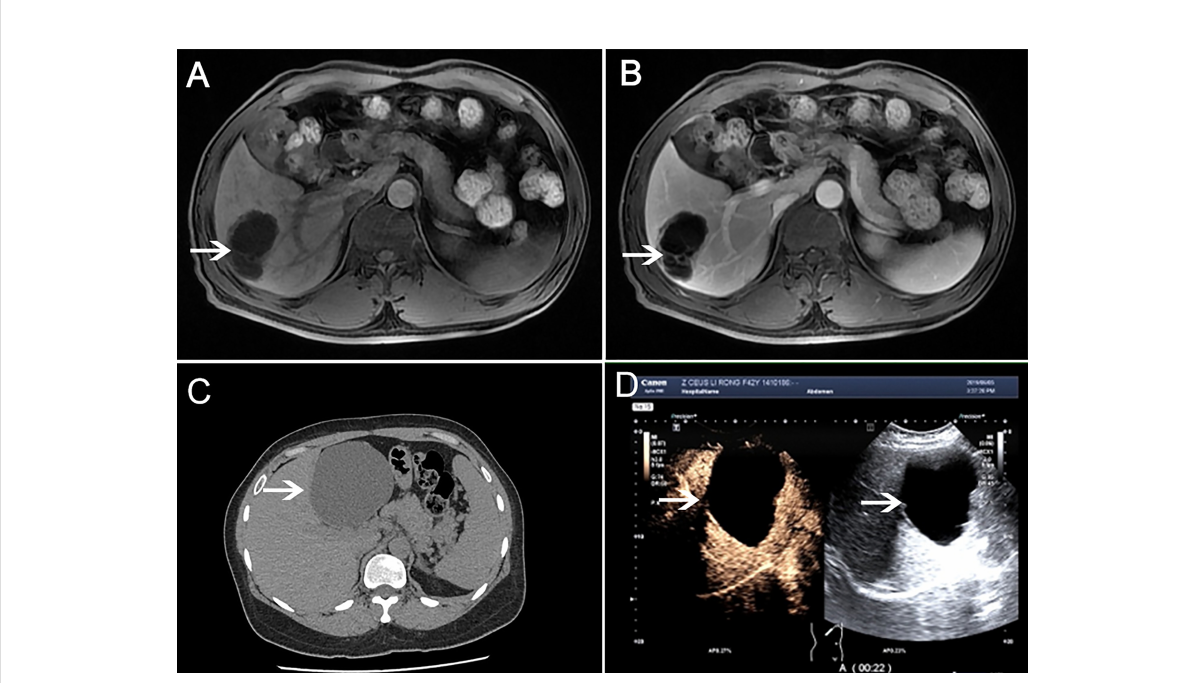
FIGURE 1 MRI examination (Case 2). (A) Multilocular cystic mass in the liver ’ s right lobe (shown by white arrow). (B) Contrast-enhanced T1-weighted images showed that the cyst wall was separated and enhanced, and there was no nodule on the cyst wall, and the contents of the lesion were not enhanced in portal vein phase. CT examination (Case 6). (C) A round low-density shadow is seen in the left lobe of the liver, with clear edges and uniform density in the capsule. (D) Contrast-enhanced liver ultrasound showed cystic space occupying the left outer lobe of the liver, with clear borders, good sound penetration in the cyst, and fl oating sheet echoes in the local area. There was no enhancement in the cysts at various stages after injection of contrast